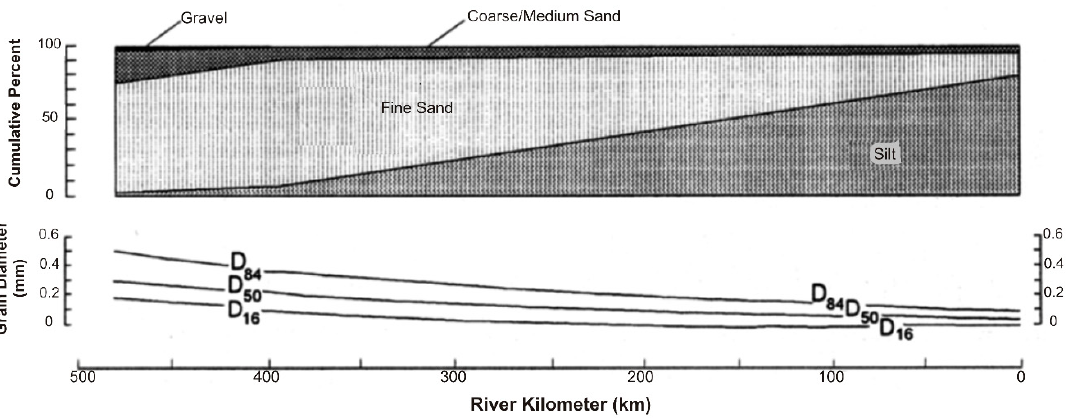
Figure 3. The riverbed materials along the study area (modified from Mossa [4]). The upper graph shows downstream changes in bed material using different terms (i.e., gravel, sand, silt, clay), and the lower graph shows grain size in numbers (i.e., D 50 is the median grain size, while D 84 and D 16 are the 84th and 16th percentiles used to represent the coarse fraction, respectively).